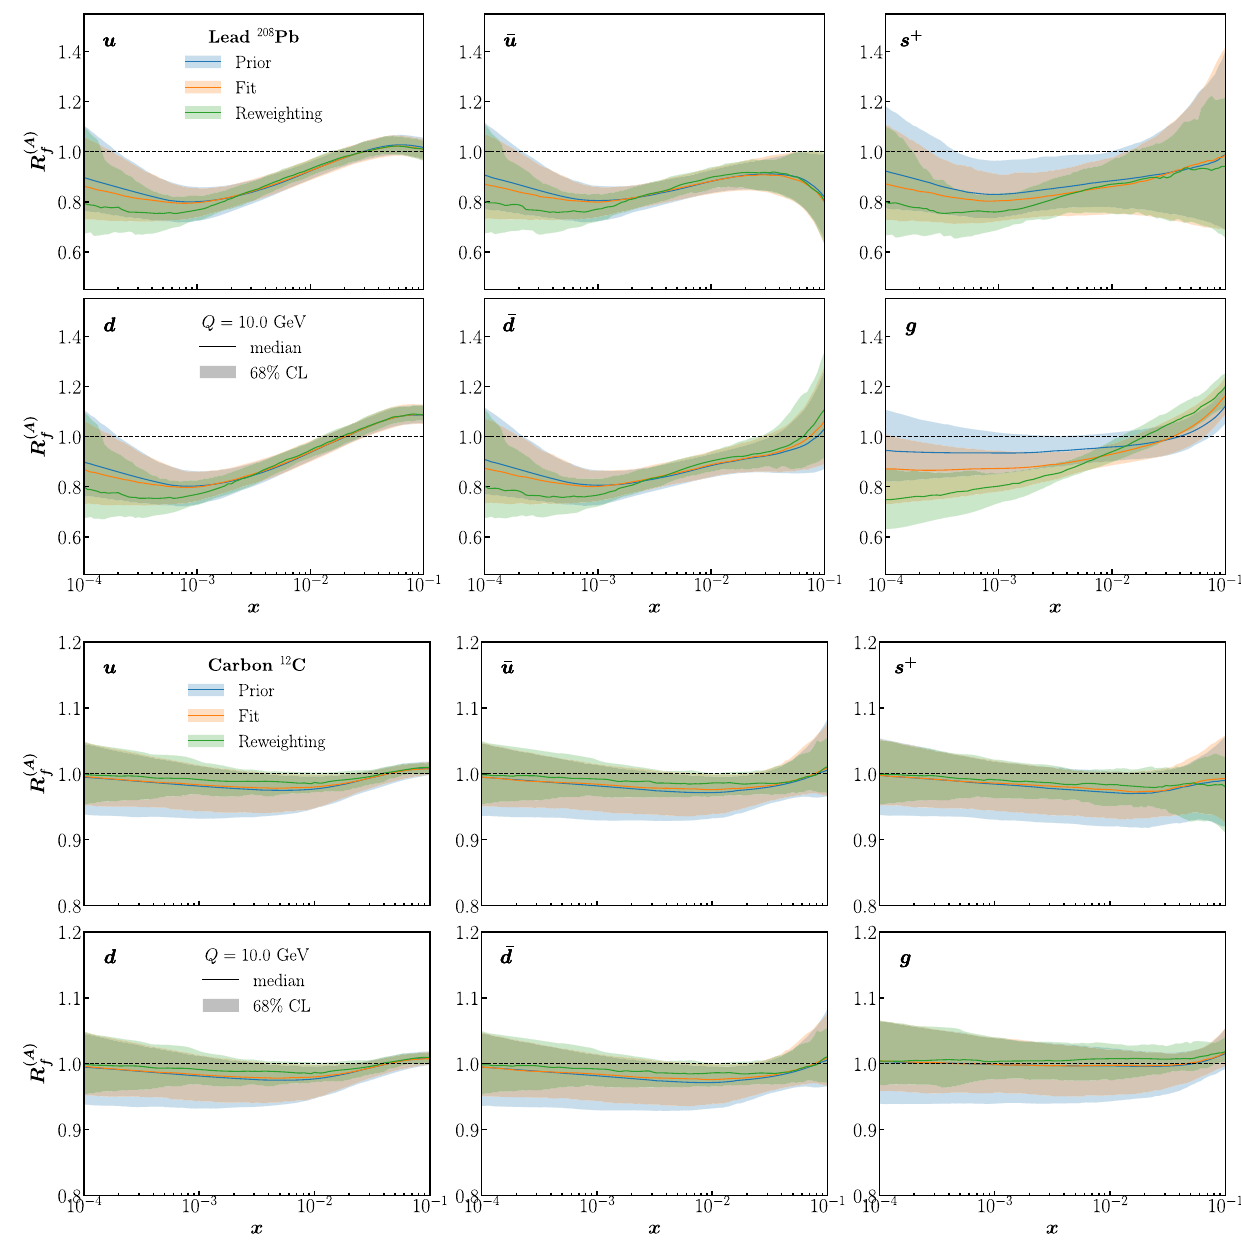
( x , Q 2 ) in nNNPDF2.0r, compared to the outcome of adding to nNNPDF2.0r the first p avg f